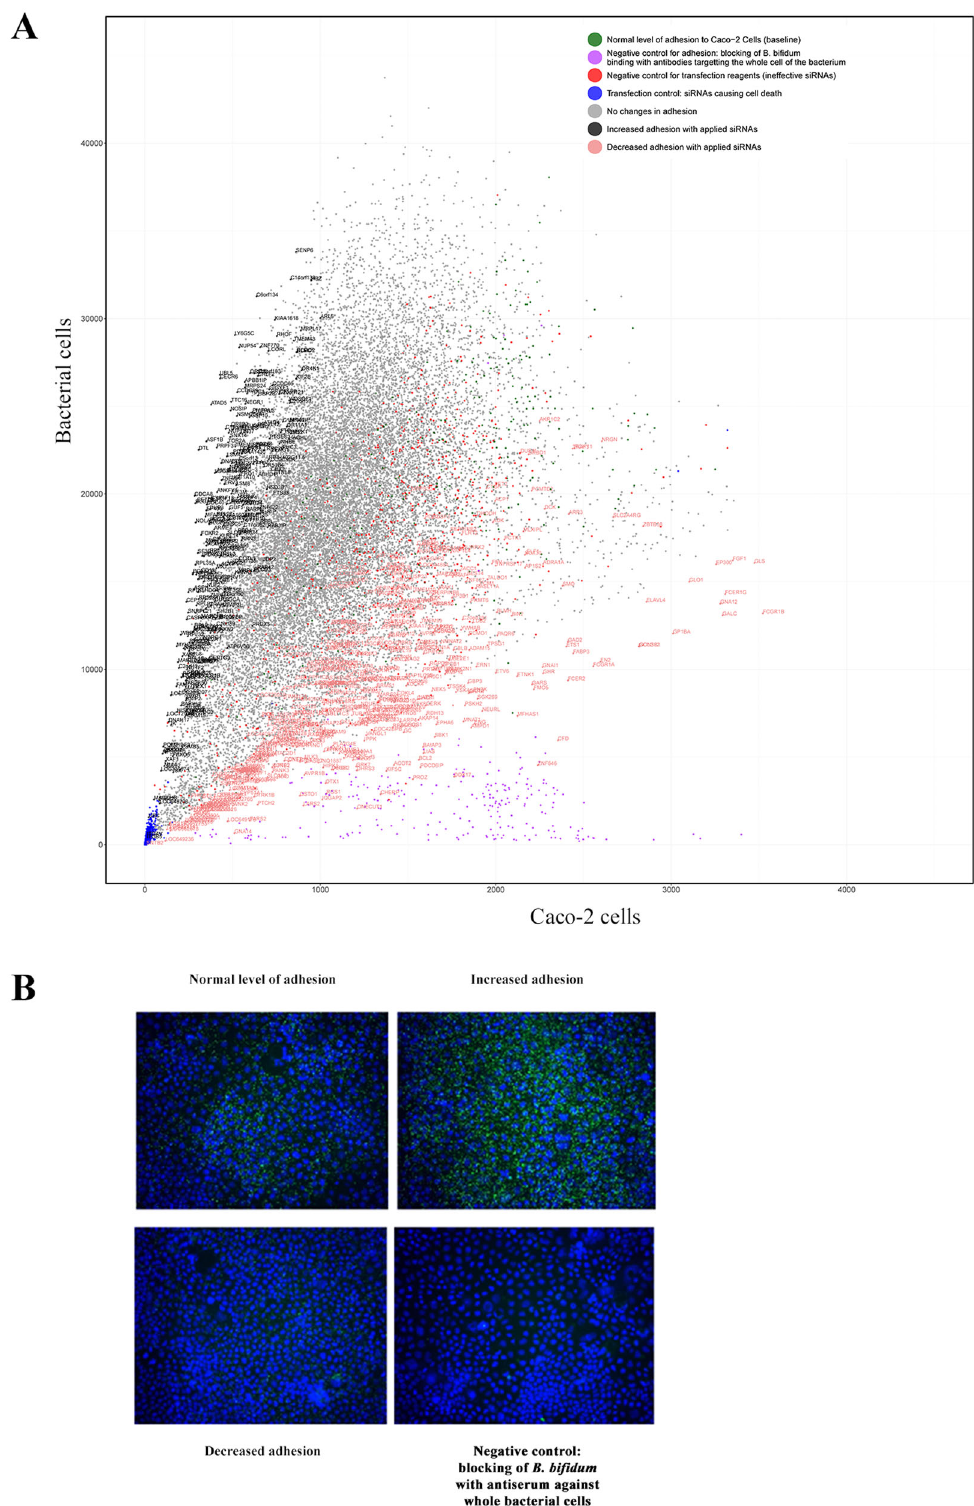
Fig. 3 Genome-wide siRNA screen reveals the silencing effect of different siRNAs in Caco-2 cell line to the adhesion level of B. bi fi dum. A Results of the genome-wide siRNA screen. The samples in which siRNAs didn´t affect the bacterial adhesion are indicated as grey and normal baseline adhesion without any siRNAs is indicated as green. Increased and decreased adhesion with speci fi c siRNAs are indicated with light purple and pink, respectively. Dark purple dots indicate the control samples in which the bacterial surface proteins were blocked with the antiserum produced against whole B. bi fi dum cells (no gene name on the dots). The samples with ineffective siRNAs (to test the effect of transfection reagents) are indicated with red dots and the samples with death siRNAs (transfection ef fi ciency controls) are indicated as bright blue dots. B Microscopic images of representative wells with B. bi fi dum adhered to siRNA-transfected Caco-2 cells and controls. The nuclei of Caco-2 cells are DAPI-stained and the B. bi fi dum cells are immunostained using the antiserum produced against whole bacterial cells and a secondary antibody with Alexa448 label and these cells appear blue and green,